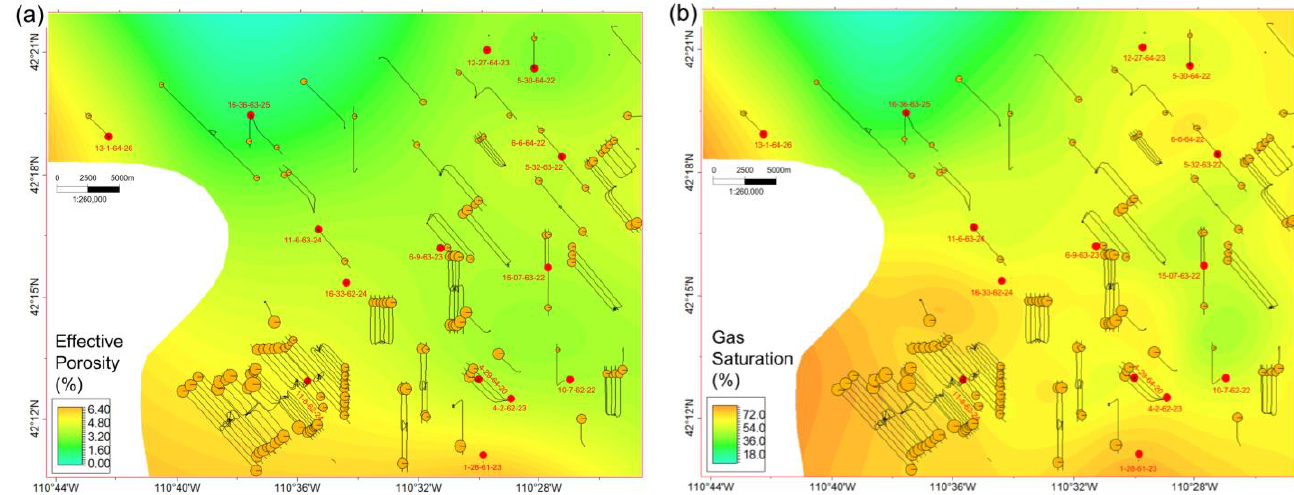
Figure 9. Map view of ( a ) effective porosity (%) and ( b ) gas saturation (%) in the studied region. The grey circle represents the one-year gas production equivalence per stage for horizontal wells, scaled by production values.